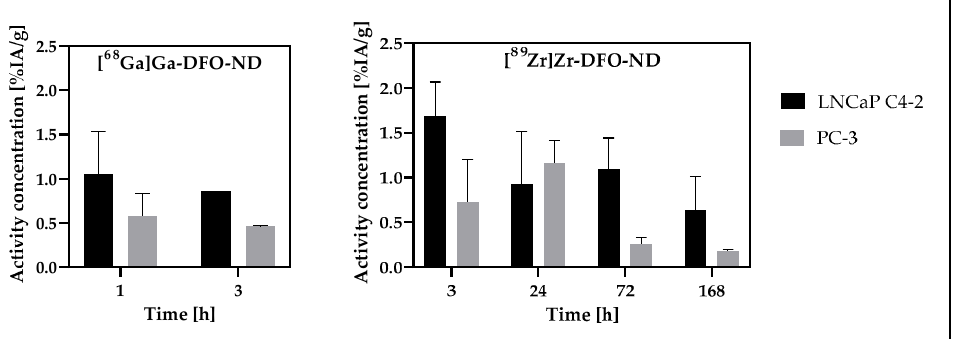
Figure 9. Tumor accumulation of radiolabeled NDs (%IA/g) in the prostate cancer tumor xenografts LNCaP C4-2 and PC-3. Mean and SD are depicted at the respective measurement time points based on gamma counter evaluation. Samples from n = 3 to n = 5 were available for each measurement time point, except [ 68 Ga]Ga-DFO-ND (3 h): LNCaP C4-2 (n = 1), PC-3 (n = 2).